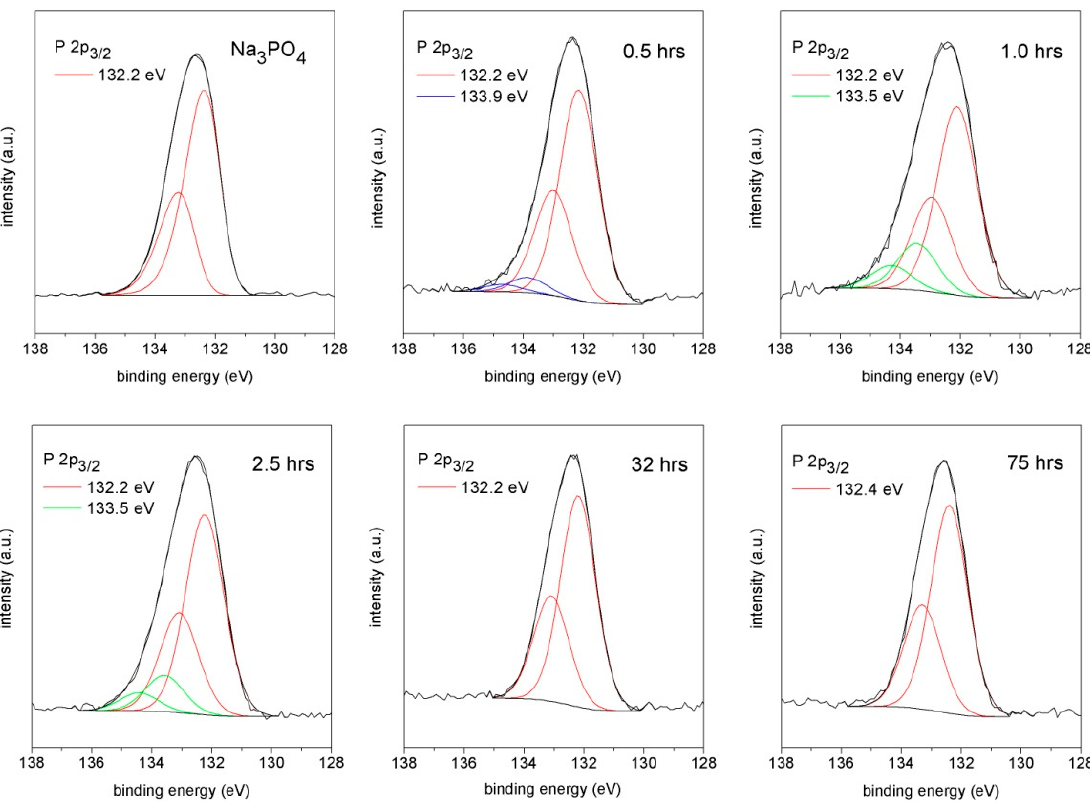
Figure 5. XPS spectra of alkali-activated BFS with Na 3 PO 4 recalculated to the 2.5 wt % addition of P 2 O 5 . (The energy separations for the P 2p 3/2 and P 2p 1/2 lines were fixed at 0.80 eV.)